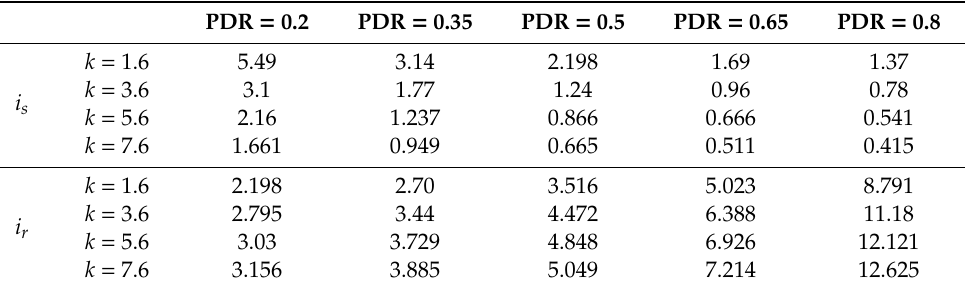
Table 3. Gear ratios of i s and i r